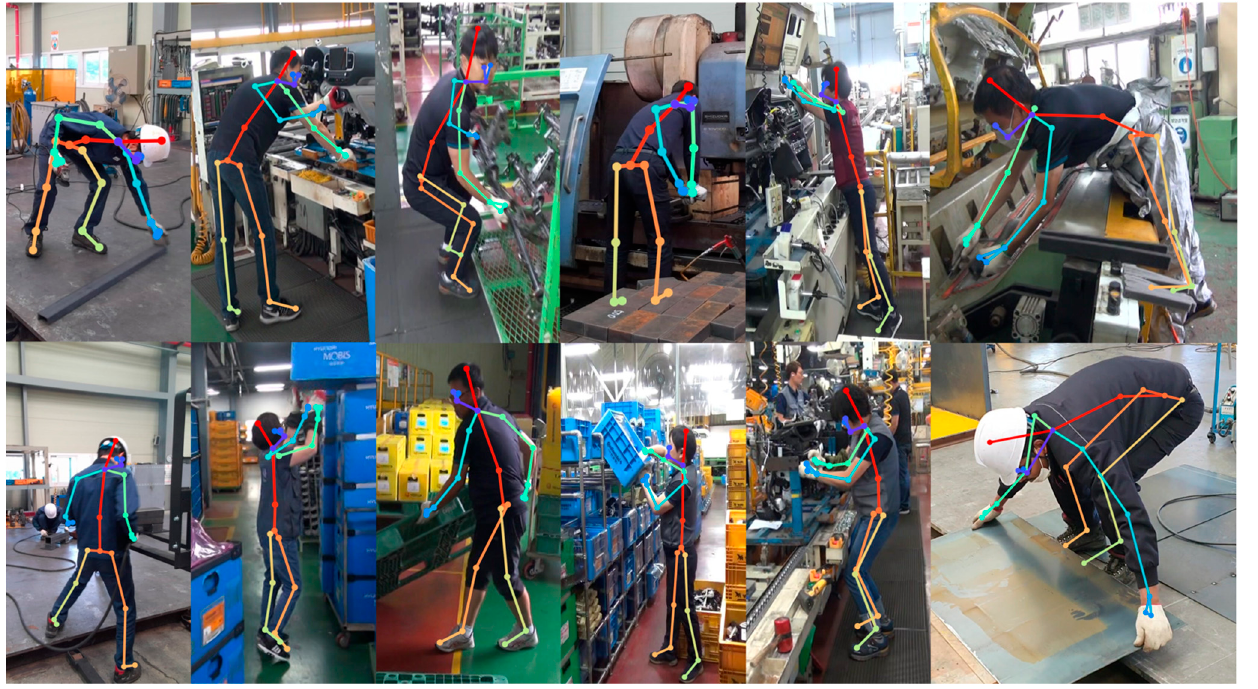
Table 4. Comparison between the results of the system and expert assessments.